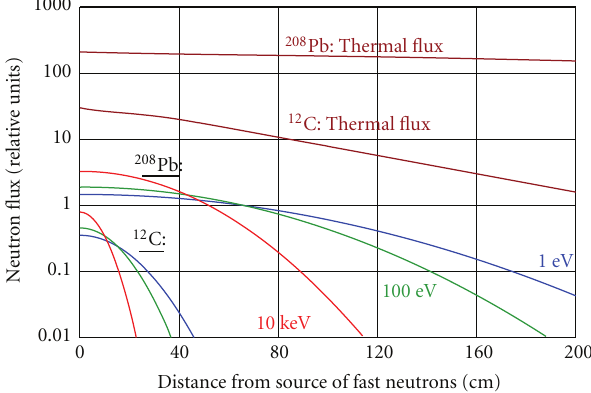
Figure 8: Fluxes of thermal and slowing-down neutrons in 208 Pb and graphite depending on distance from ADS target.